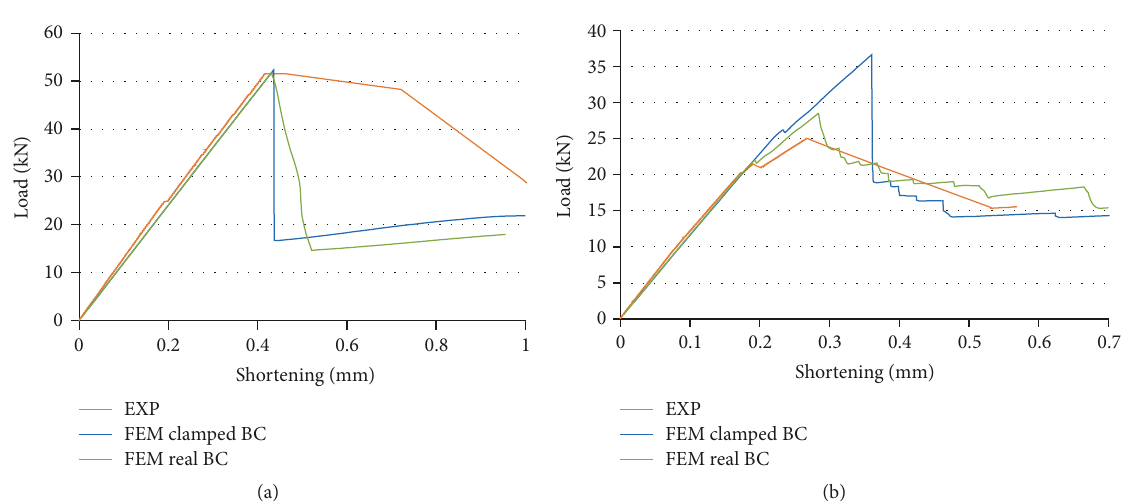
Figure 10: Experimental and predicted load-shortening curves for the shell R34 without cutout (a) and shell R35 with a cutout (b).